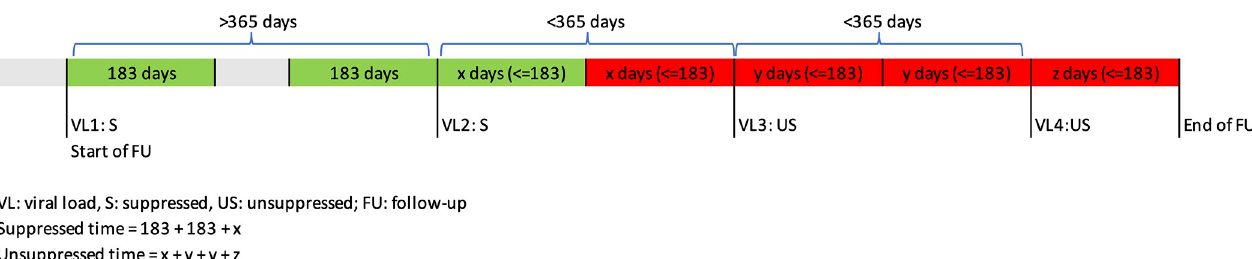
Fig 1. Example of allocation of unsuppressed and suppressed time. Cumulative unsuppressed or suppressed time was the time during which we assumed that a patient had HIV VL above or below the limit of detection, respectively. Follow-up time was defined as a sum of cumulative unsuppressed and suppressed time and started on the date of the first VL test and ended on the date of the last VL test plus 183 days. When two consecutive VL tests showed the same result, either viraemia or suppression, the time in between both tests was considered unsuppressed or suppressed. When two consecutive VL tests showed different results, the time in between both tests was divided in half, adding both unsuppressed and suppressed time. When the time between two VL tests was more than 365 days, a maximum of 183 days was added to either unsuppressed or suppressed time.